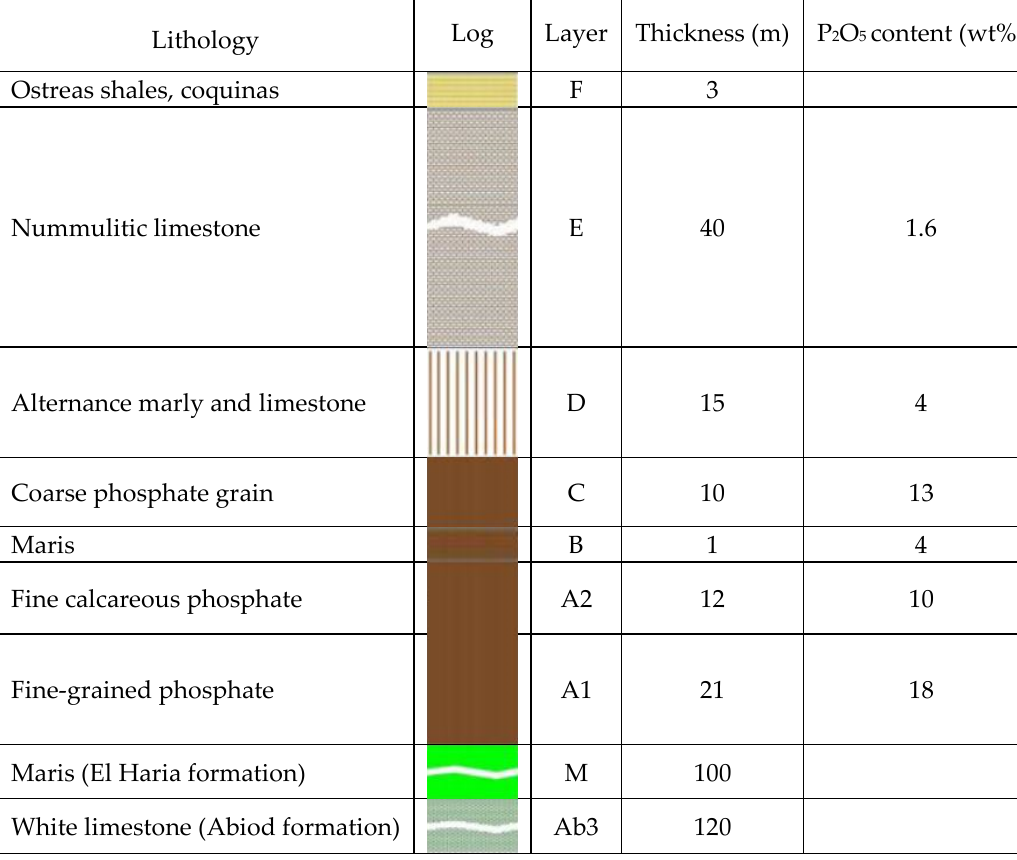
Figure 2. Stratigraphic information of the Sra Ouertane deposit in Northern Tunisia [16]. Samples from layers A1, A2, and C of the Sra Ouertane phosphate rock deposit were used for